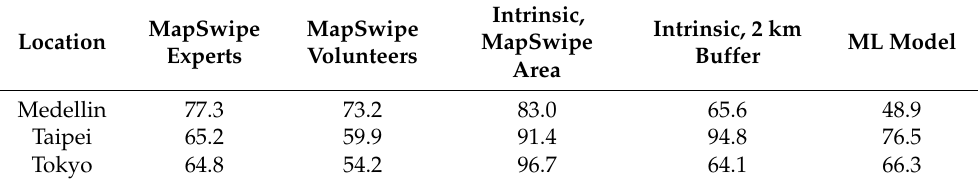
Table 7. Comparison of MapSwipe completeness assessment with a saturation-curve fitting approach and the prediction of OSM buildings by a machine learning model by Herfort et al. [13]. All values are given as percentages. For MapSwipe, the values represent the share of cells that were flagged as incomplete by volunteers or by experts. Tiles without buildings were not incorporated in the calculation. For the intrinsic approach, the comparison was made by relating the fitted asymptote of the saturation curve with the observed count for September 2020. For the machine learning model, the comparison is made between number of buildings observed at the date of the analysis and the predicted building footprints by the model. Both approaches used for comparison were not applicable for